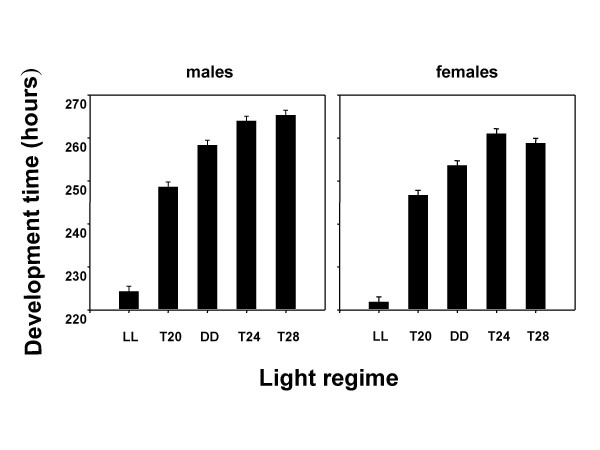
Mean pre-adult development time of D. melanogaster populations in five different light regimes. Light regime is plotted along x-axis, and pre-adult developmental time in hours along y-axis. Mean development time of males is shown in the left panels, while those for females in the right panels. The error bars represent 95% CI around the mean. ANOVA revealed significant effect of light regime (F4,12 = 2411.97, p < 0.001), sex (F1,3 = 607.85, p < 0.001), and light regime × sex interaction (F4,12 = 6.56, p < 0.05). The mean pre-adult development time values are provided in table1.